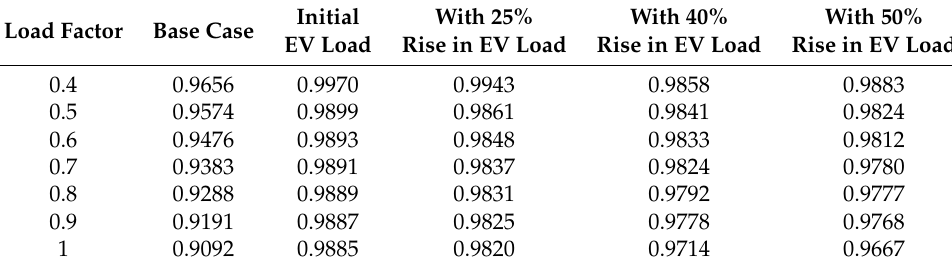
Table 16. Impact on the minimum distribution bus node 69-bus radial DST.